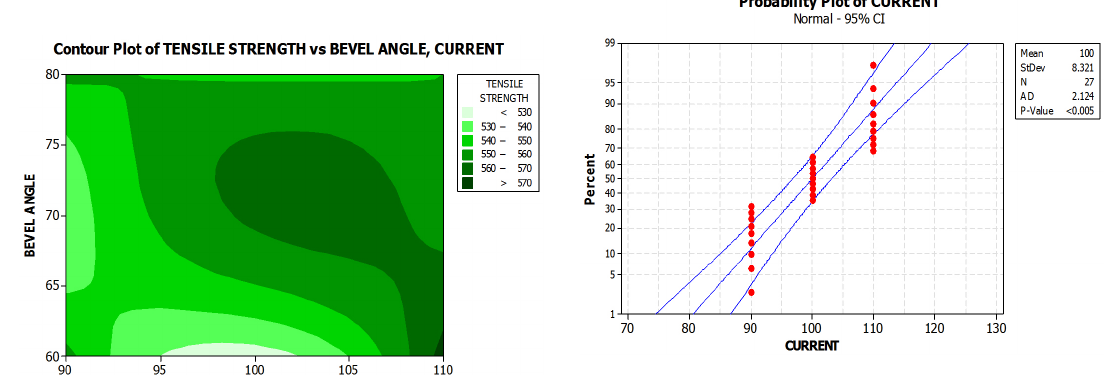
Figure 6. Probability plot of current.